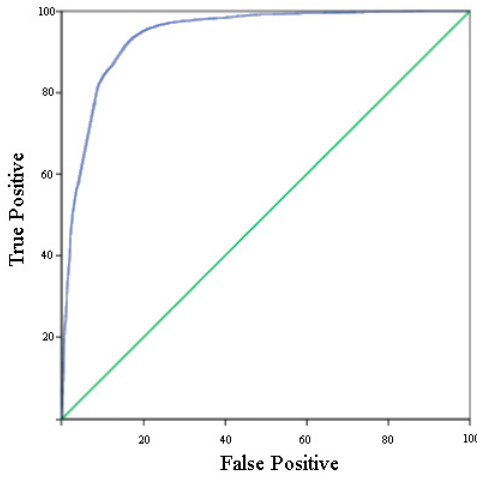
Figure 5. Relative operating characteristics (ROC) curve.